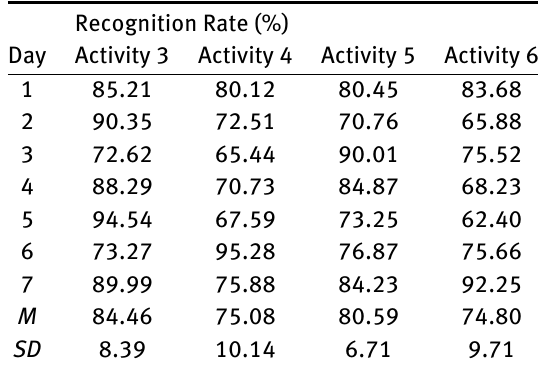
Figure 8: Example of recognition for Activity 1 with 84.62 % recog- nition rate. The dashed part represents the time interval where the activity was identified by the system, while the plain area repre- sents the activity duration observed by a human annotator.